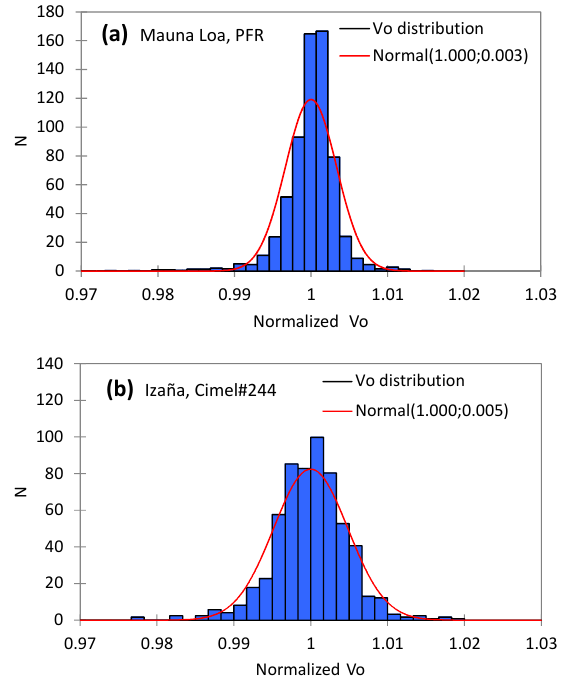
Figure 5. Histogram of daily extraterrestrial voltages ( V 0 ) at the 500nm wavelength normalized by the temporal trend: (a) at Mauna Loa using GAW-PFR data (2000–2014); (b) at Izaña us- ing AERONET no. 244 (2012–2016). Red lines indicate a normal distribution (with the given parameters).